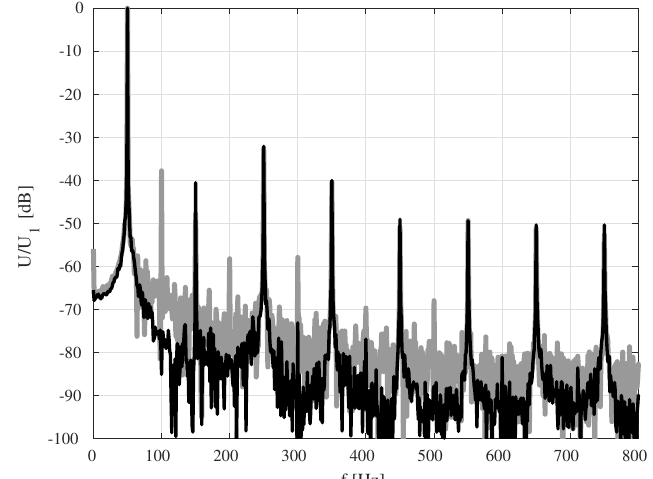
Figure 12. Fragment of frequency spectra of input voltage (black) and output voltage